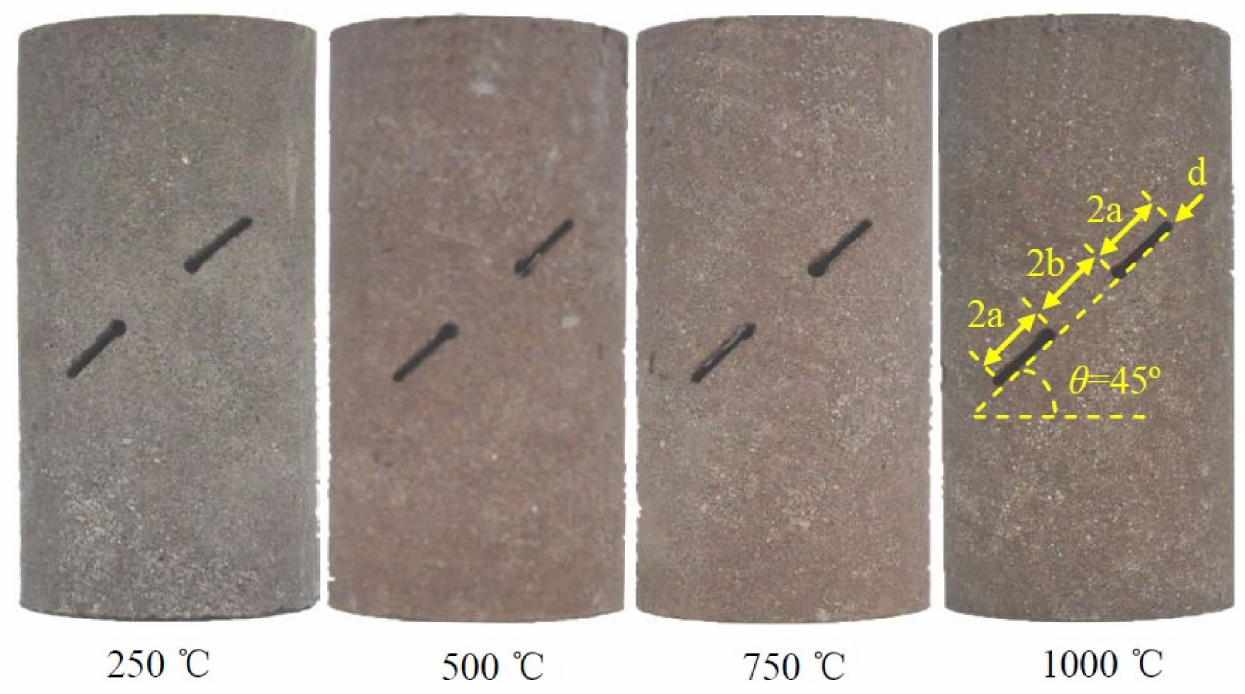
Figure 1. Pre-cracked red sandstone specimens after exposure to different pre-treatment